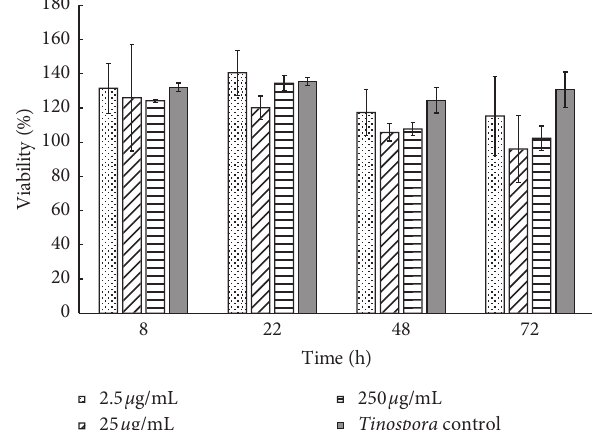
Figure 5: Cellular viability of 3T3 cell line incubated at different times of TEC-NPs in three concentrations (mean% ±